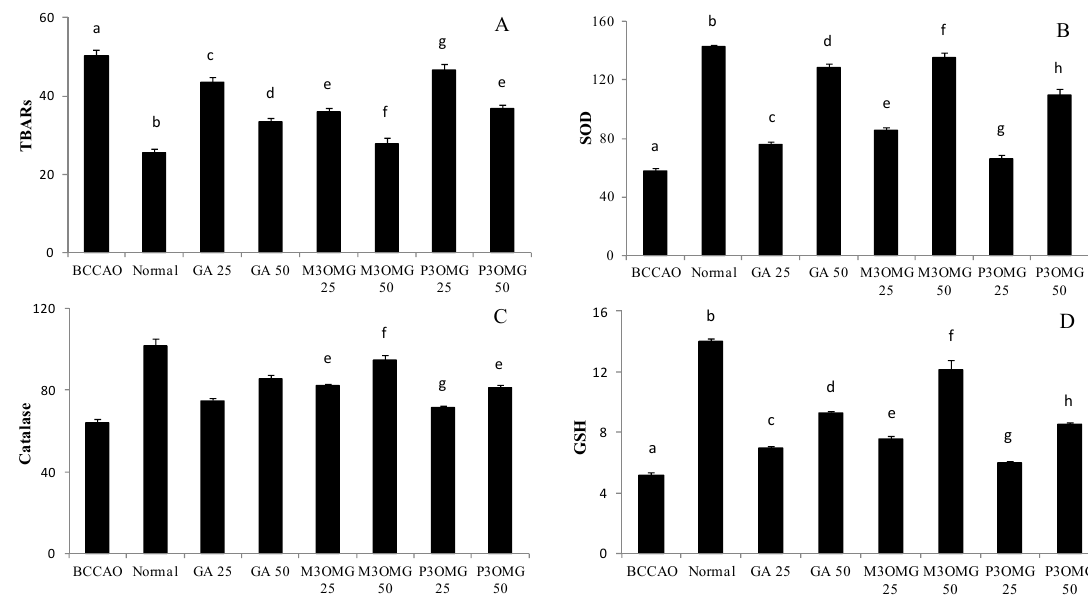
Figure 7. Effects of intraperitoneal administration of GA, M3OMG and P3OMG on oxidative stress levels in mouse brain tissue: TBARS levels, expressed as nmol MDA eq/g tissues ( A ); SOD activity, expressed as U/mg per protein ( B ); Cat activity, expressed as μ g/mg per protein ( C ); and GSH levels, expressed as μ g/mg per protein ( D ). Data are a mean ± SD ( n = 7); different letters indicate statistically significant differences ( p < 0.01) between the two groups.